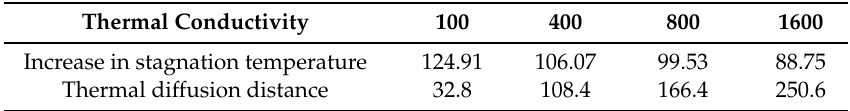
Table 4. Material thermal conductivity and aircraft temperature field 1